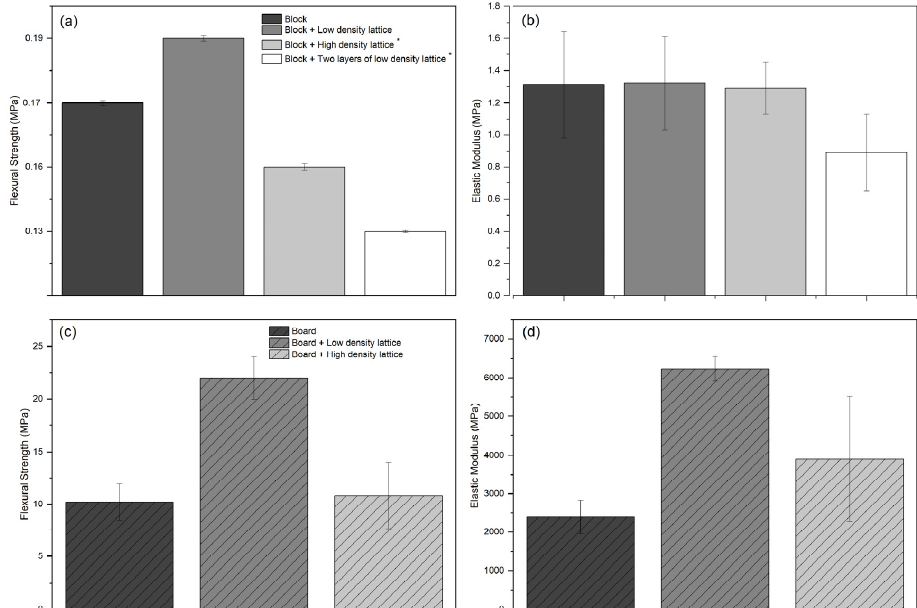
Figure 9 . Flexural properties, including strength and elastic modulus: ( a ) Flexural strength of light ‐ weight blocks; ( b ) Elastic modulus in flexure of lightweight blocks; ( c ) Flexural strength of dense boards; ( d ) Elastic modulus in flexure of dense boards. * Shear failure was observed, further expla ‐ nation is given in the text.